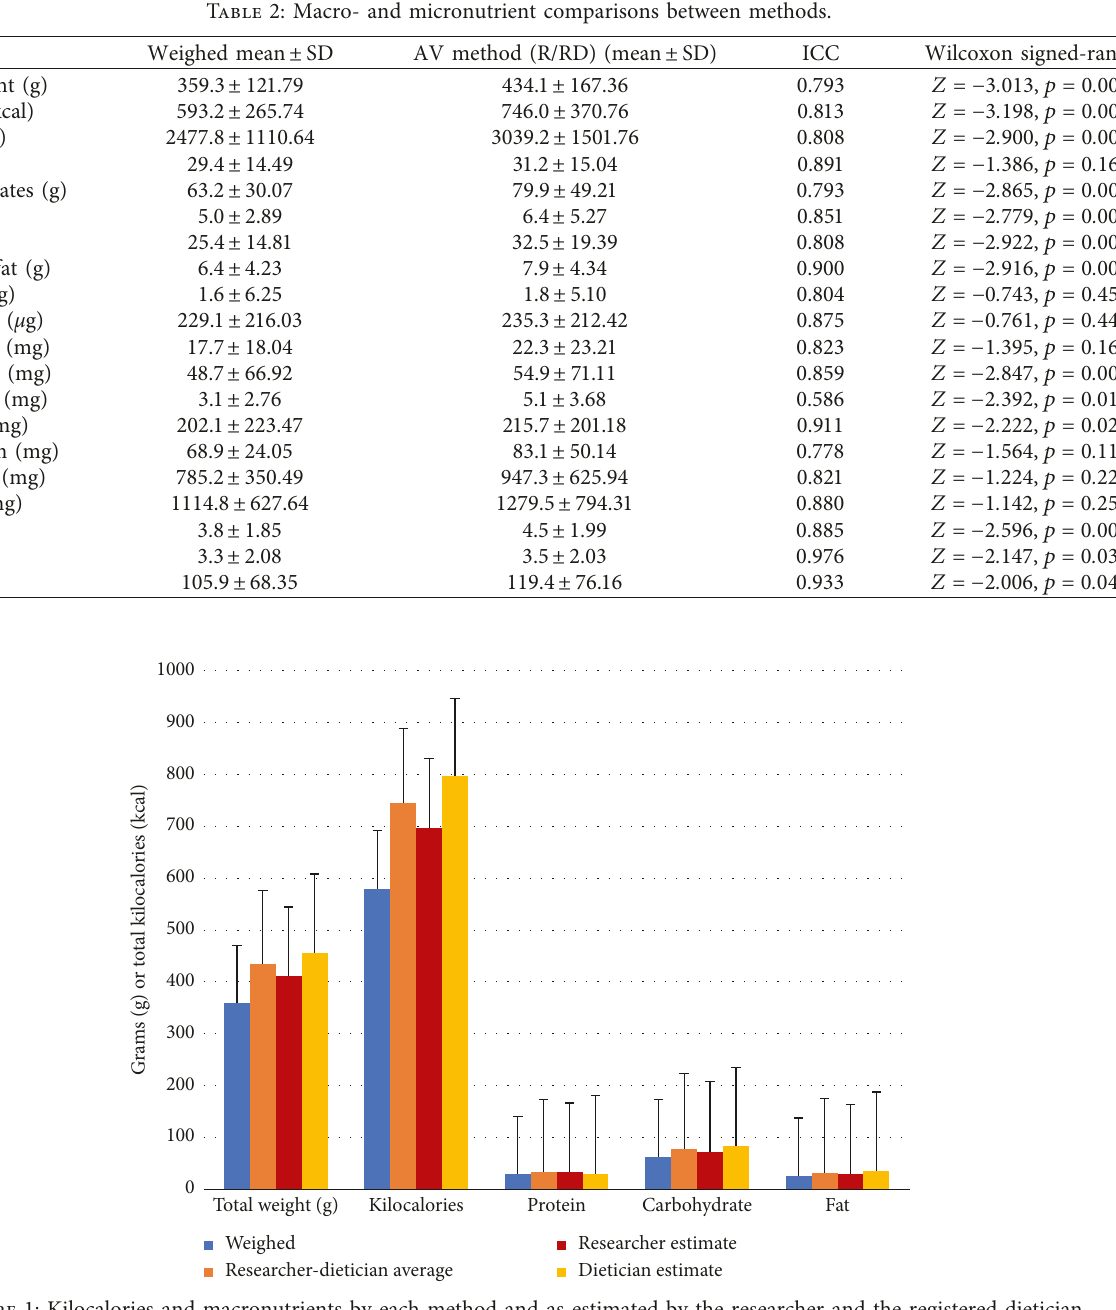
Figure 1: Kilocalories and macronutrients by each method and as estimated by the researcher and the registered